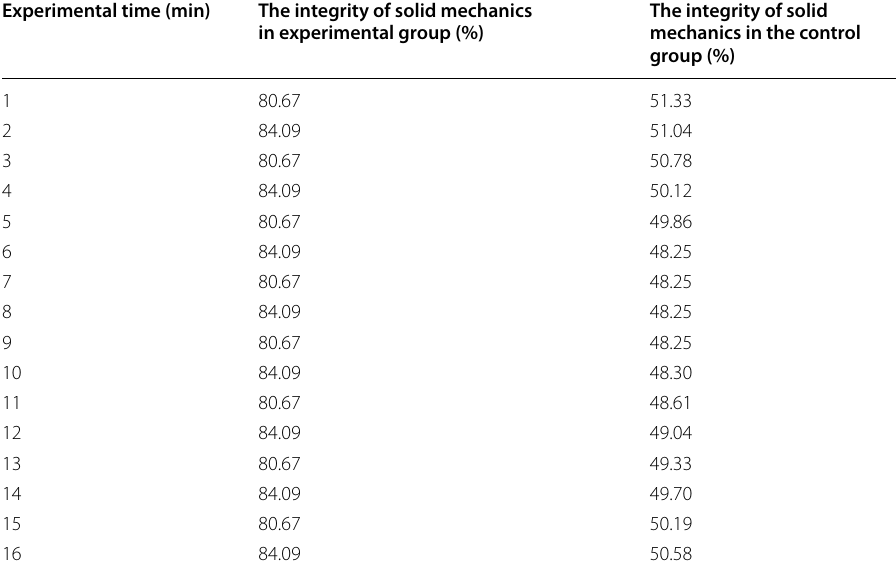
Table 6 Comparison of integrity of solid mechanics computing (operation status of high mechanical parameter) Experimental time (min) The integrity of solid mechanics in experimental group (%)